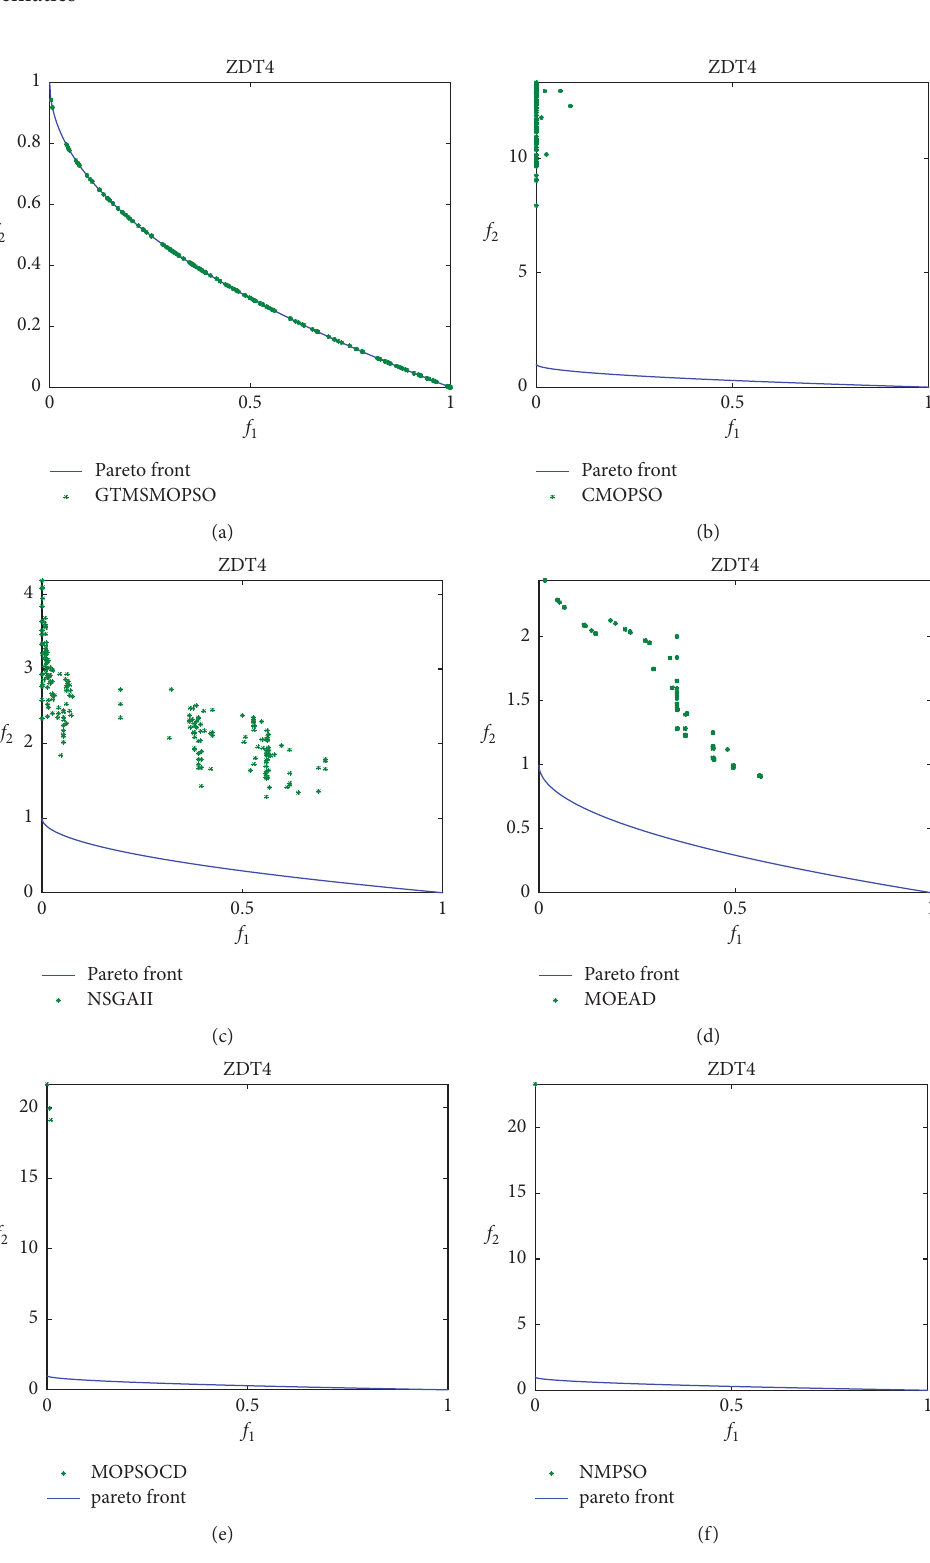
outperforms the other three multiobjective intelligent al- gorithms in the UF series of test functions.